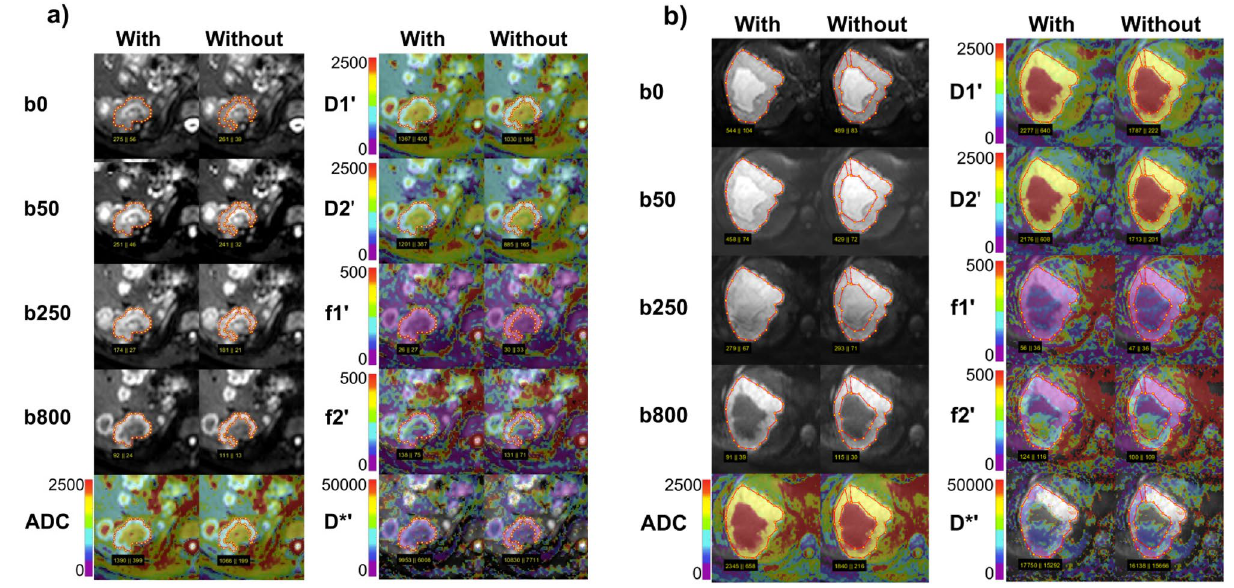
Figure 3. Typical examples of DWI IVIM analysis comparing in- and exclusion of necrosis in a metastasis of colorectal carcinoma ( a ) and of liquid in a hemangioma ( b ) at 1.5 T. For one central slice per lesion, original diffusion-weighted images with b = 0, 50, 250, 800 s/mm 2 are presented together with conventional ADC, diffusion sensitive D 1 ′ and D 2 ′ parameter maps, and perfusion sensitive f 1 ′ , f 2 ′ , D* ′ parameter maps. The parameter maps are displayed as color-coded overlays over b = 800. Values of ADC, D 1 ′ , D 2 ′ and D* ′ are given in units of 10 –6 mm 2 /s, those of f 1 ′ and f 2 ′ in 10 −3 . If bad data quality led to negative parameter values or to not defined values, these voxels were not colorized. When necrosis/cystic components were excluded (“Without”) from regions of interests (ROIs), the diffusion sensitive parameters were significantly lower compared to inclusion (“With”). Perfusion sensitive parameters remained unchanged because there is only low perfusion in the metastasis and hemangioma